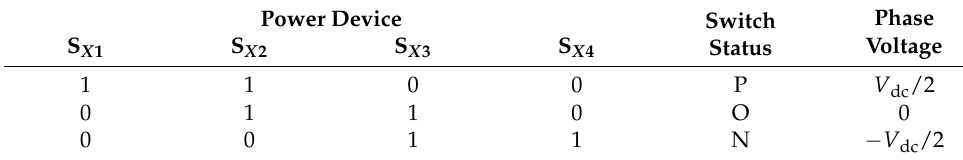
Table 1. The definition of switching state for three